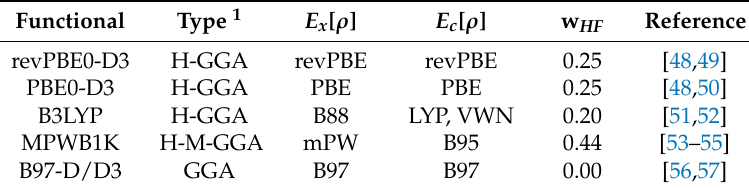
Table 1. Composition of the exchange-correlation density functionals used along this review.